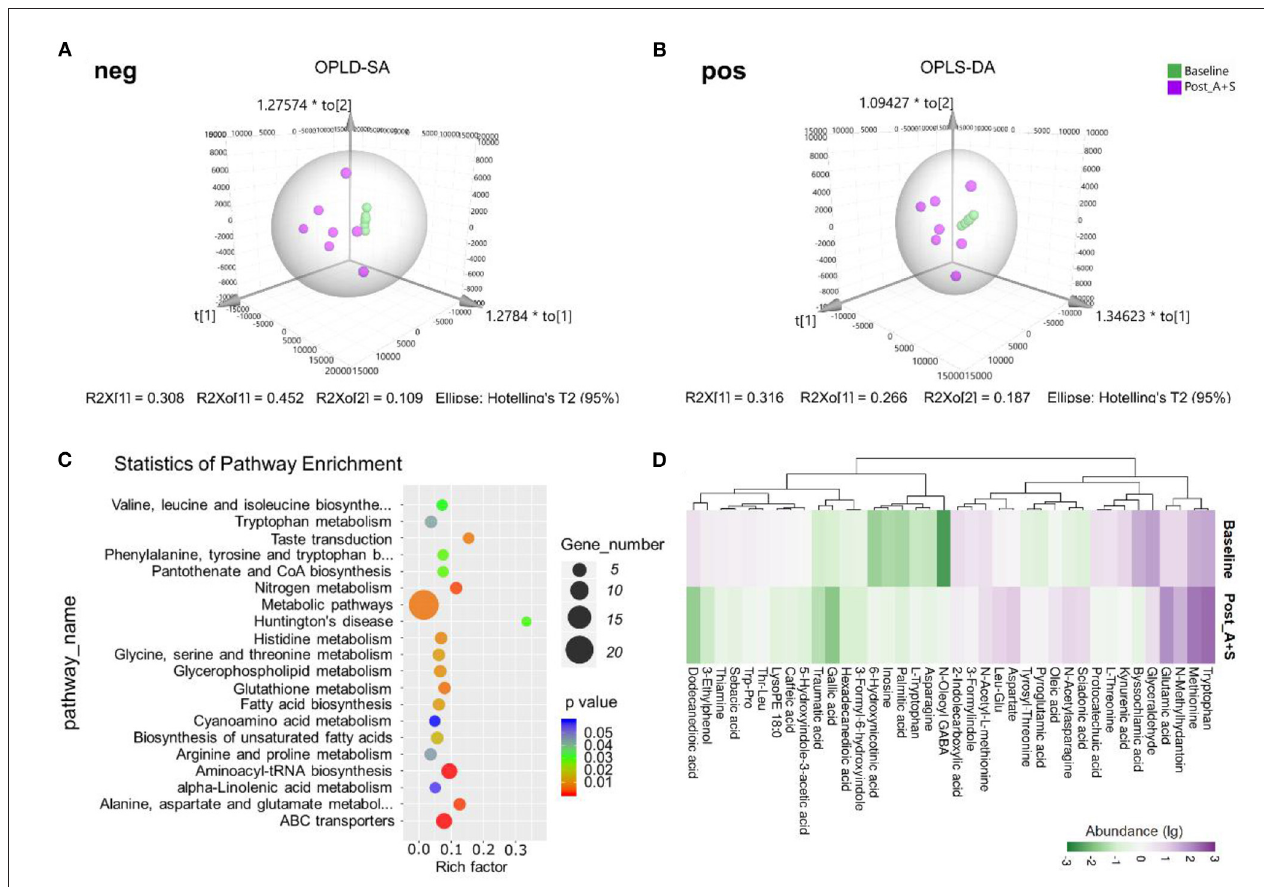
FIGURE 4 | Effects of anesthesia/surgery on fecal metabolomic profiles. (A) OPLD-SA in the negative ion mode. (B) OPLD-SA in the positive-ion mode. (C) The Kyoto Encyclopedia of Genes and Genomes (KEGG) pathway enrichment analysis of the dysregulated metabolites. (D) The abundance of metabolites in the post_A + S and baseline samples ( n = 7 for both baseline and post_A + S